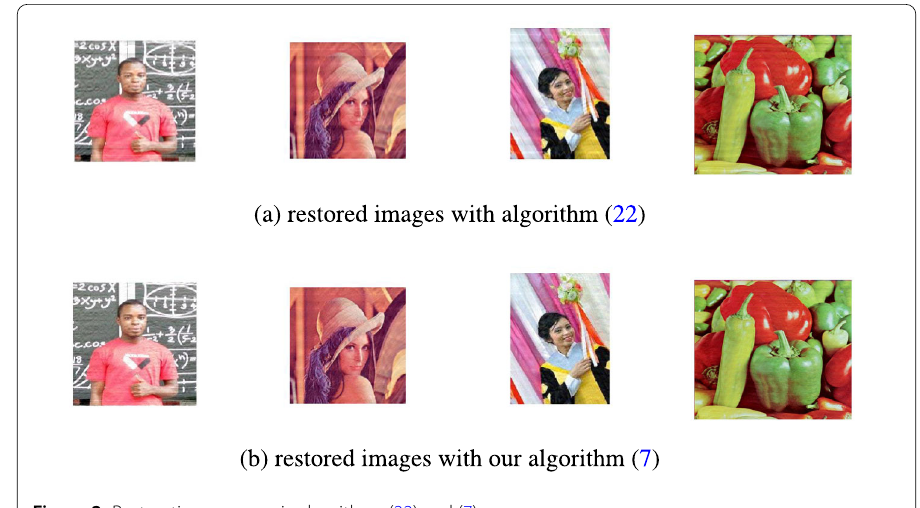
Figure 2 Restoration process via algorithms (22) and (7)